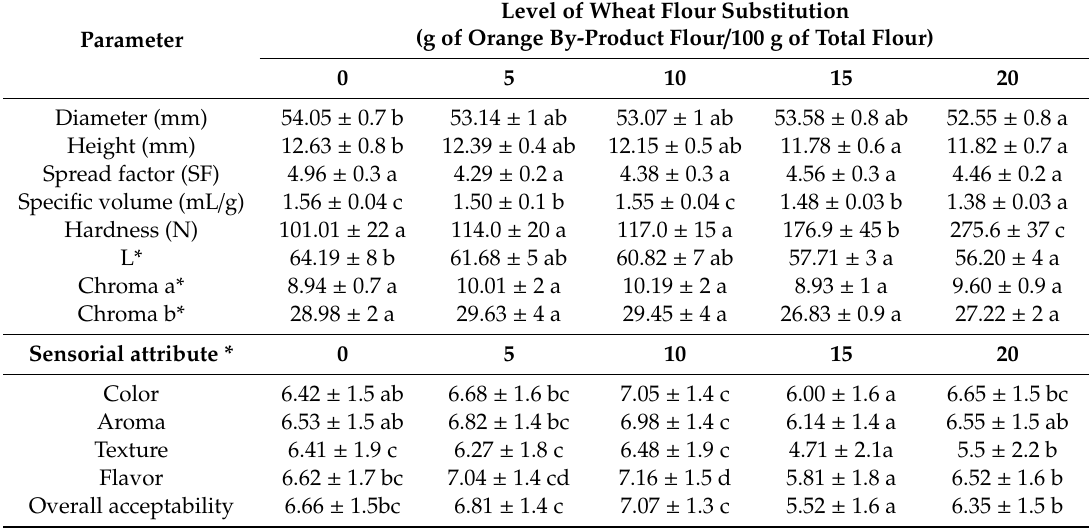
Table 4. Physical characteristics and sensorial analysis results of cookies produced by wheat flour substitution with orange by-product flour at di ff erent